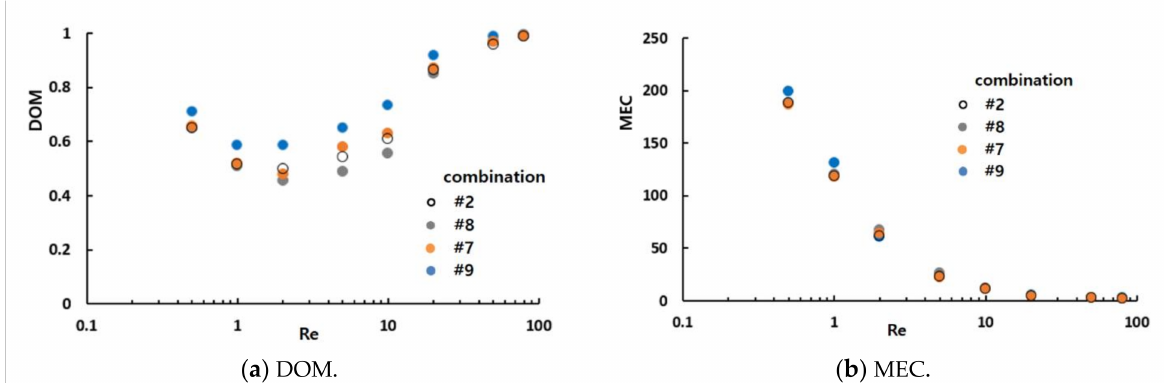
Figure 14. Comparison of the mixing performance of the four combinations.